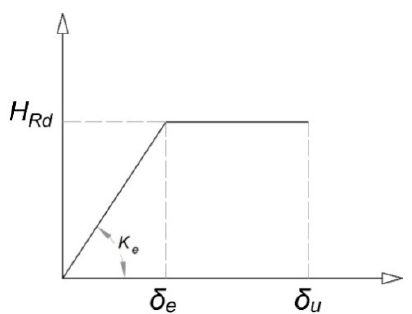
Figure 9. Bi-linear envelope, shear behavior masonry walls.